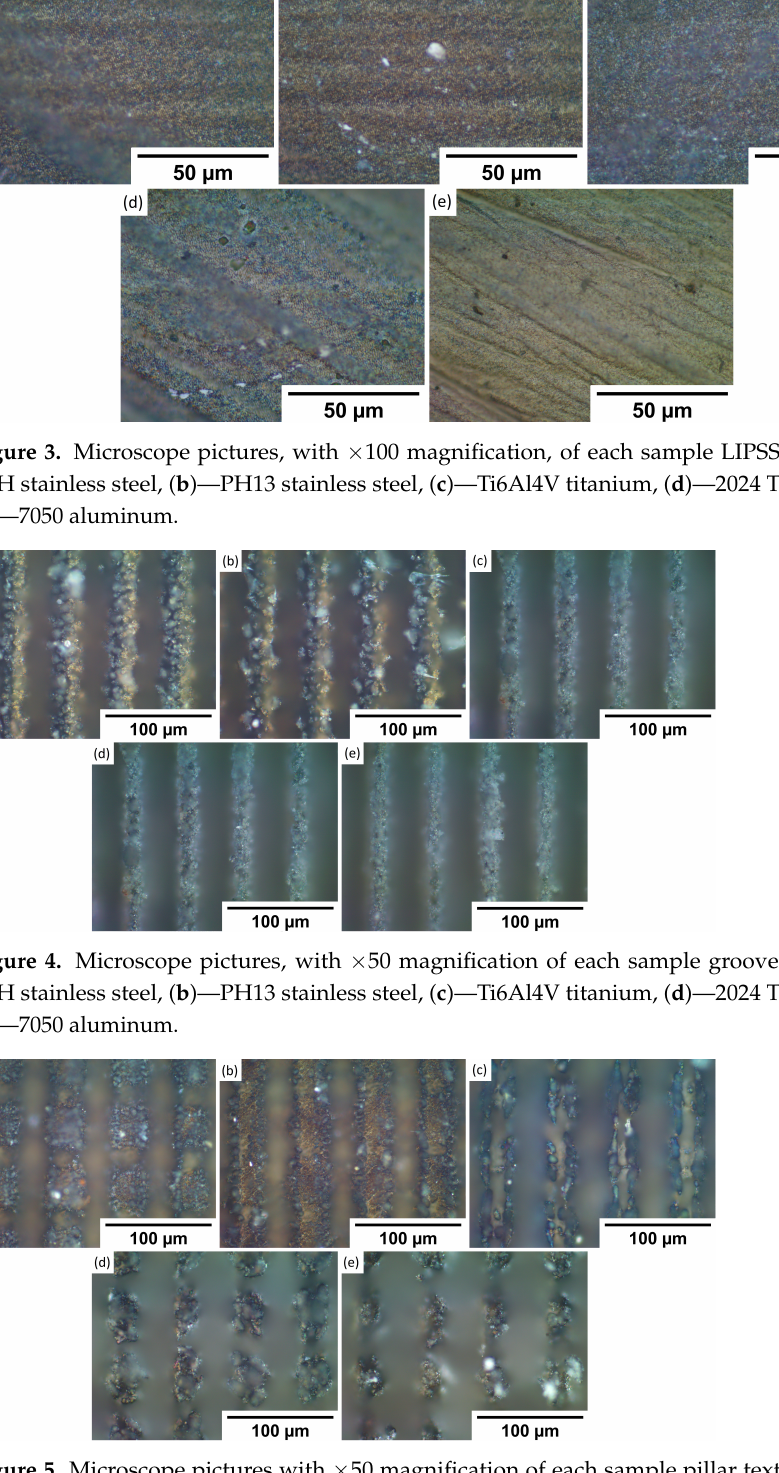
Figure 5. Microscope pictures with × 50 magnification of each sample pillar texture. ( a )—17-4PH stainless steel, ( b )—PH13 stainless steel, ( c )—Ti6Al4V titanium, ( d )—2024 T3 aluminum, and ( e )— 7050